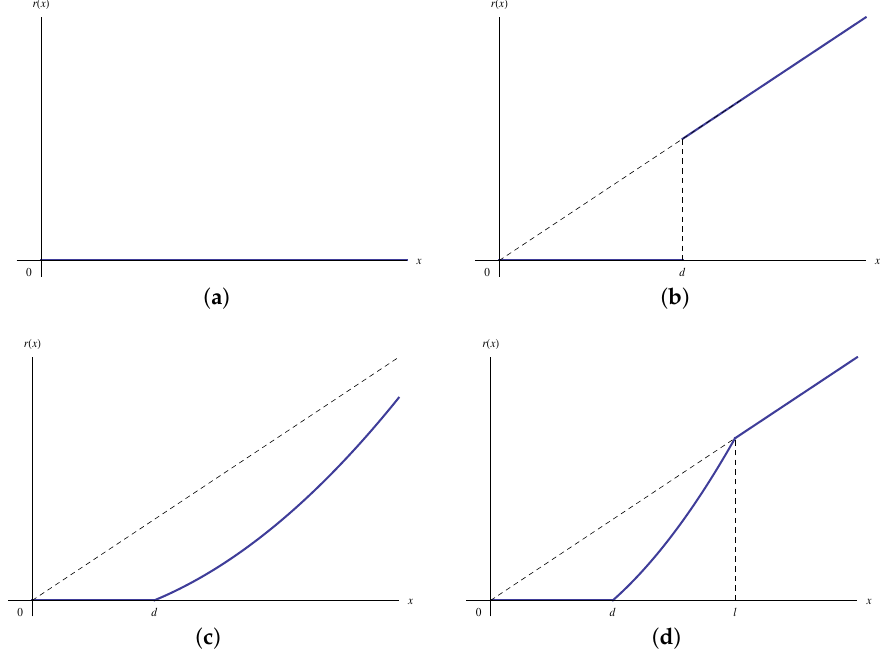
Figure 2. Four possible structures of optimal indemnity fuction r ∗ . ( a ) noninsurance; ( b ) noninsurance followed by full insurance; ( c ) noninsurance followed by coinsurance insurance; ( d ) noninsurance followed by coinsurance and then full